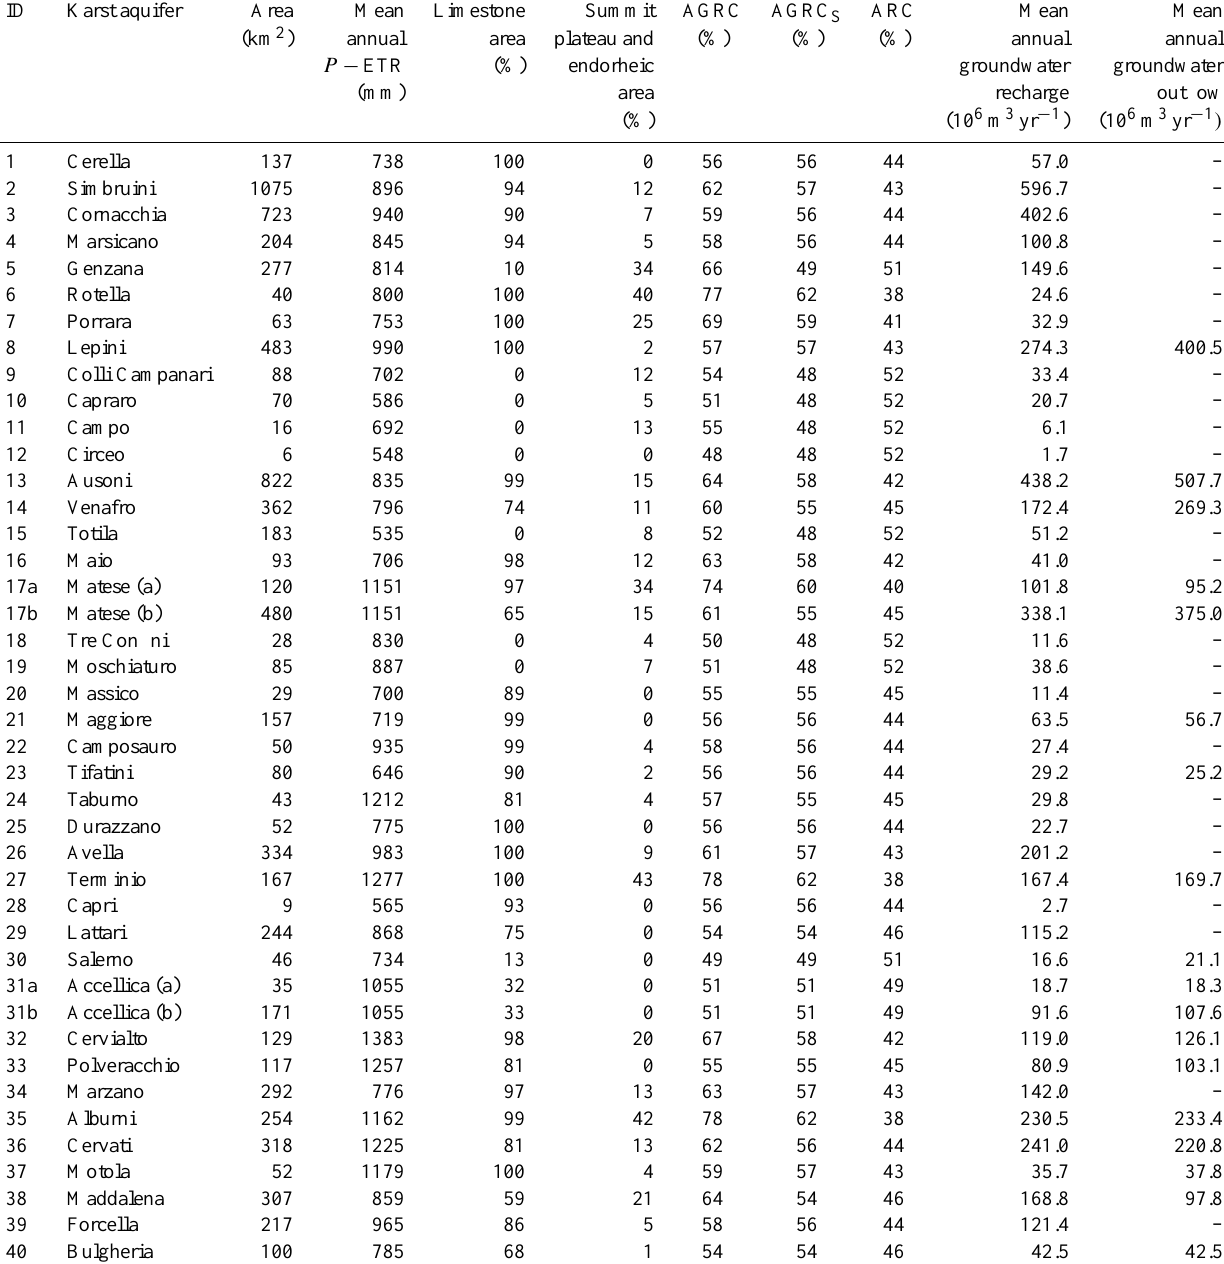
Table 2. Data and estimations of AGRC, AGRC S , ARC and mean annual groundwater recharge for karst aquifers of the study area. In the last column, the mean annual groundwater outflow, estimated for some of the karst aquifers by other hydrogeological studies (Celico, 1983; Allocca et al., 2007) are reported; values estimated in this study for the four sample karst aquifers (ID 17a, 27, 31a and 32) are